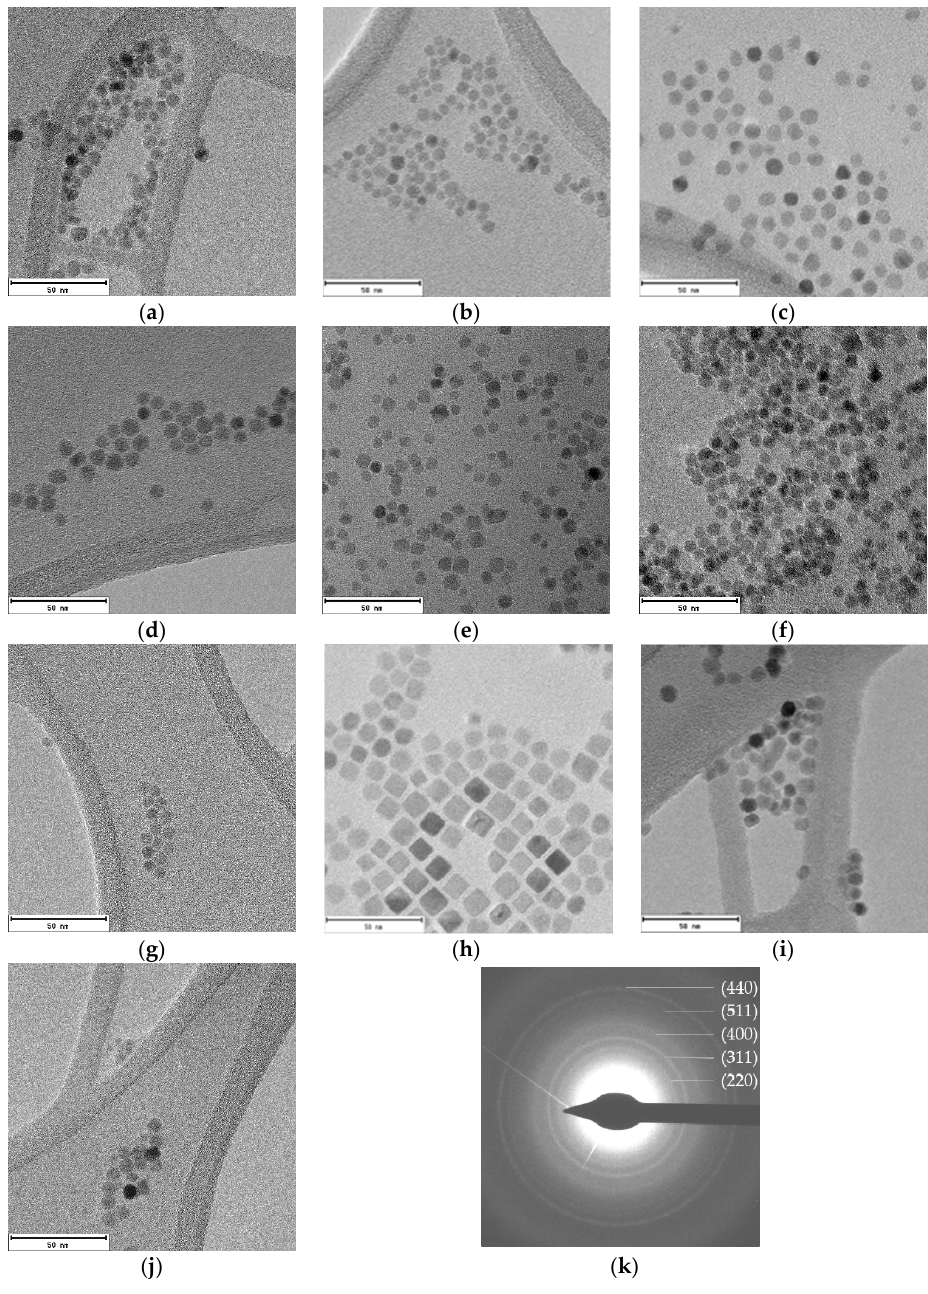
Figure 3. TEM images of cobalt-doped ferrite nanoparticles synthesized using different reflux times: ( a ) Co 0.15 _30; ( b ) Co 0.15 _45; ( c ) Co 0.15 _60; ( d ) Co 0.10 _60; ( e ) Co 0.04 _60; ( f ) Co 0.01 _60; ( g ) Co 0.15 _75; ( h ) Co 0.15 _90; ( i ) Co 0.15 _105 and ( j ) Co 0.15 _120; and ( k ) the electron diffraction pattern obtained for the Co30 sample is also provided. Scale bar: 50